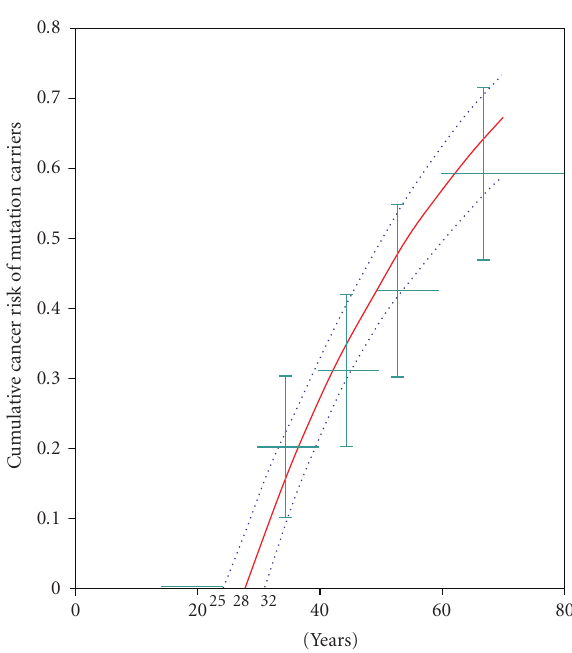
Figure 1: Cumulative risk of cancer for MSH2 and MLH1 mutation carriers. Individuals are not di ff erentiated with respect to the mutated gene or gender. The five horizontal blue lines indicate the risk for each of the 5 groups as shown in Table 1. For the youngest group, the risk was evaluated to zero. For the other four groups, the vertical line is placed at the median age and indicates the 0.68 confidence interval for the evaluated risk. The red curve shows the risk evaluated assuming that it follows a modified Weibull distribution as a function of age. The two flanking dotted graphs indicate the 0.68 confidence interval of this evaluation. The age at onset of the risk is evaluated to 28 (0.68 confidence interval = 25–32